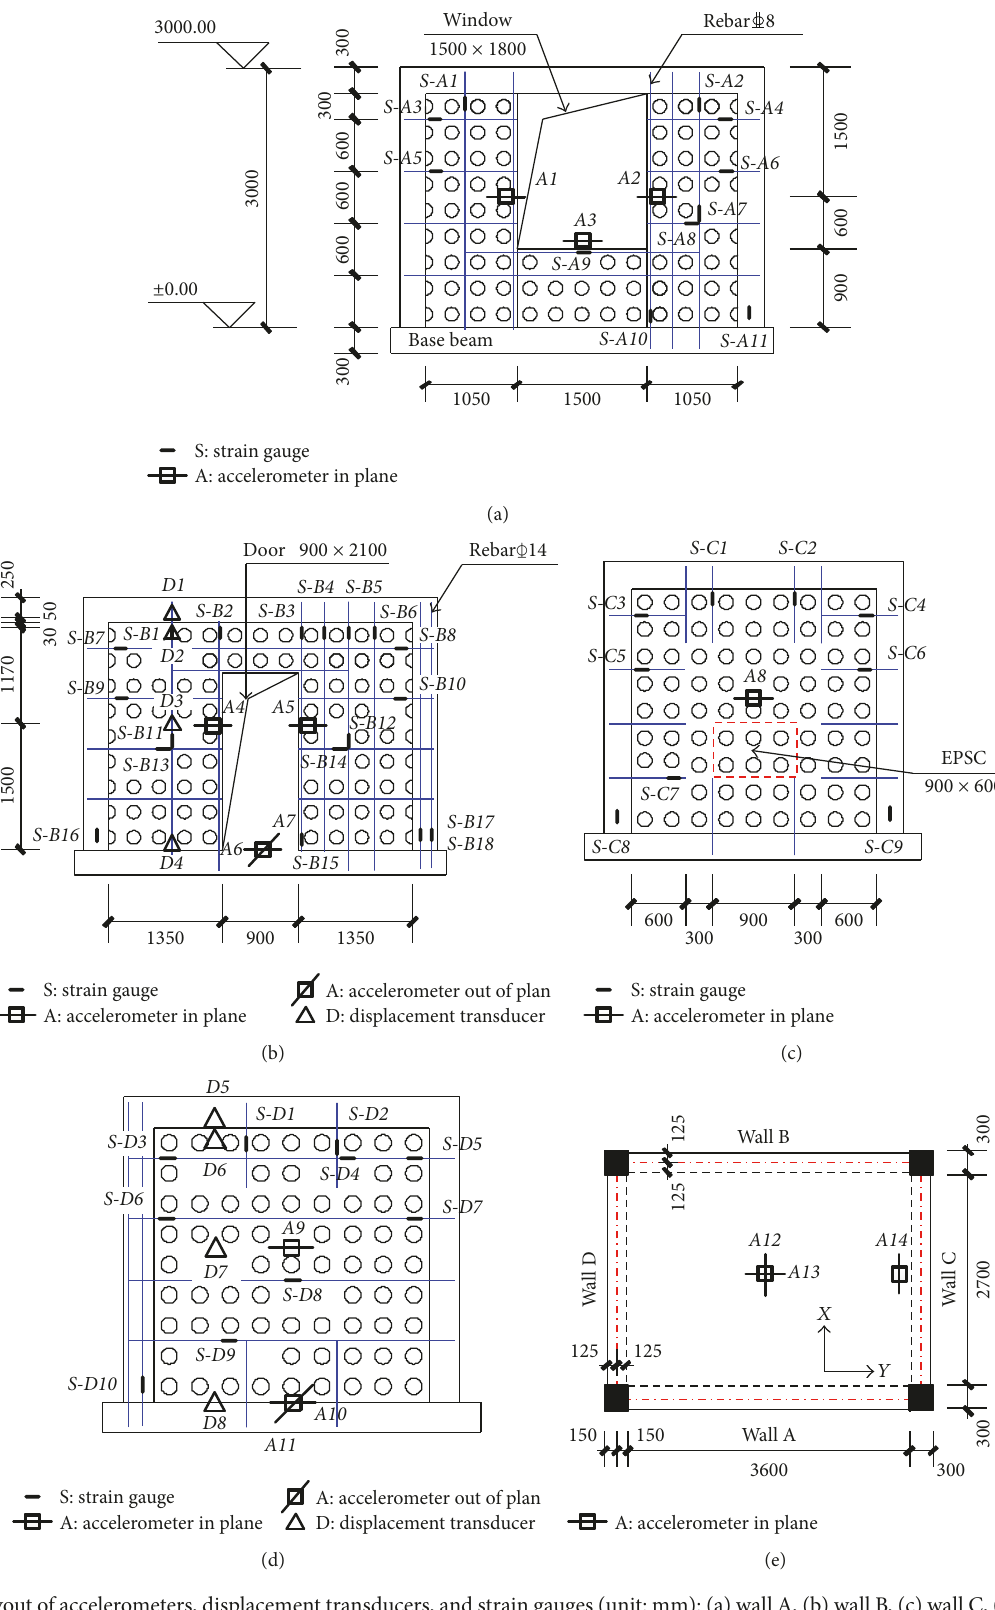
Figure 8: Layout of accelerometers, displacement transducers, and strain gauges (unit: mm): (a) wall A, (b) wall B, (c) wall C, (d) wall D, and (e)